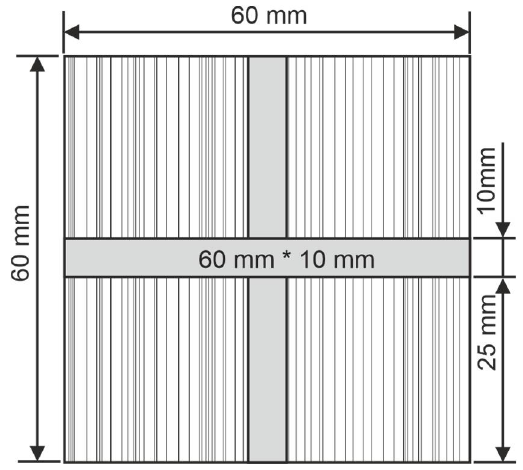
Figure 3. Microscopic sample preparation of the ultrasonic impregnated fiber-reinforced polymer composites.